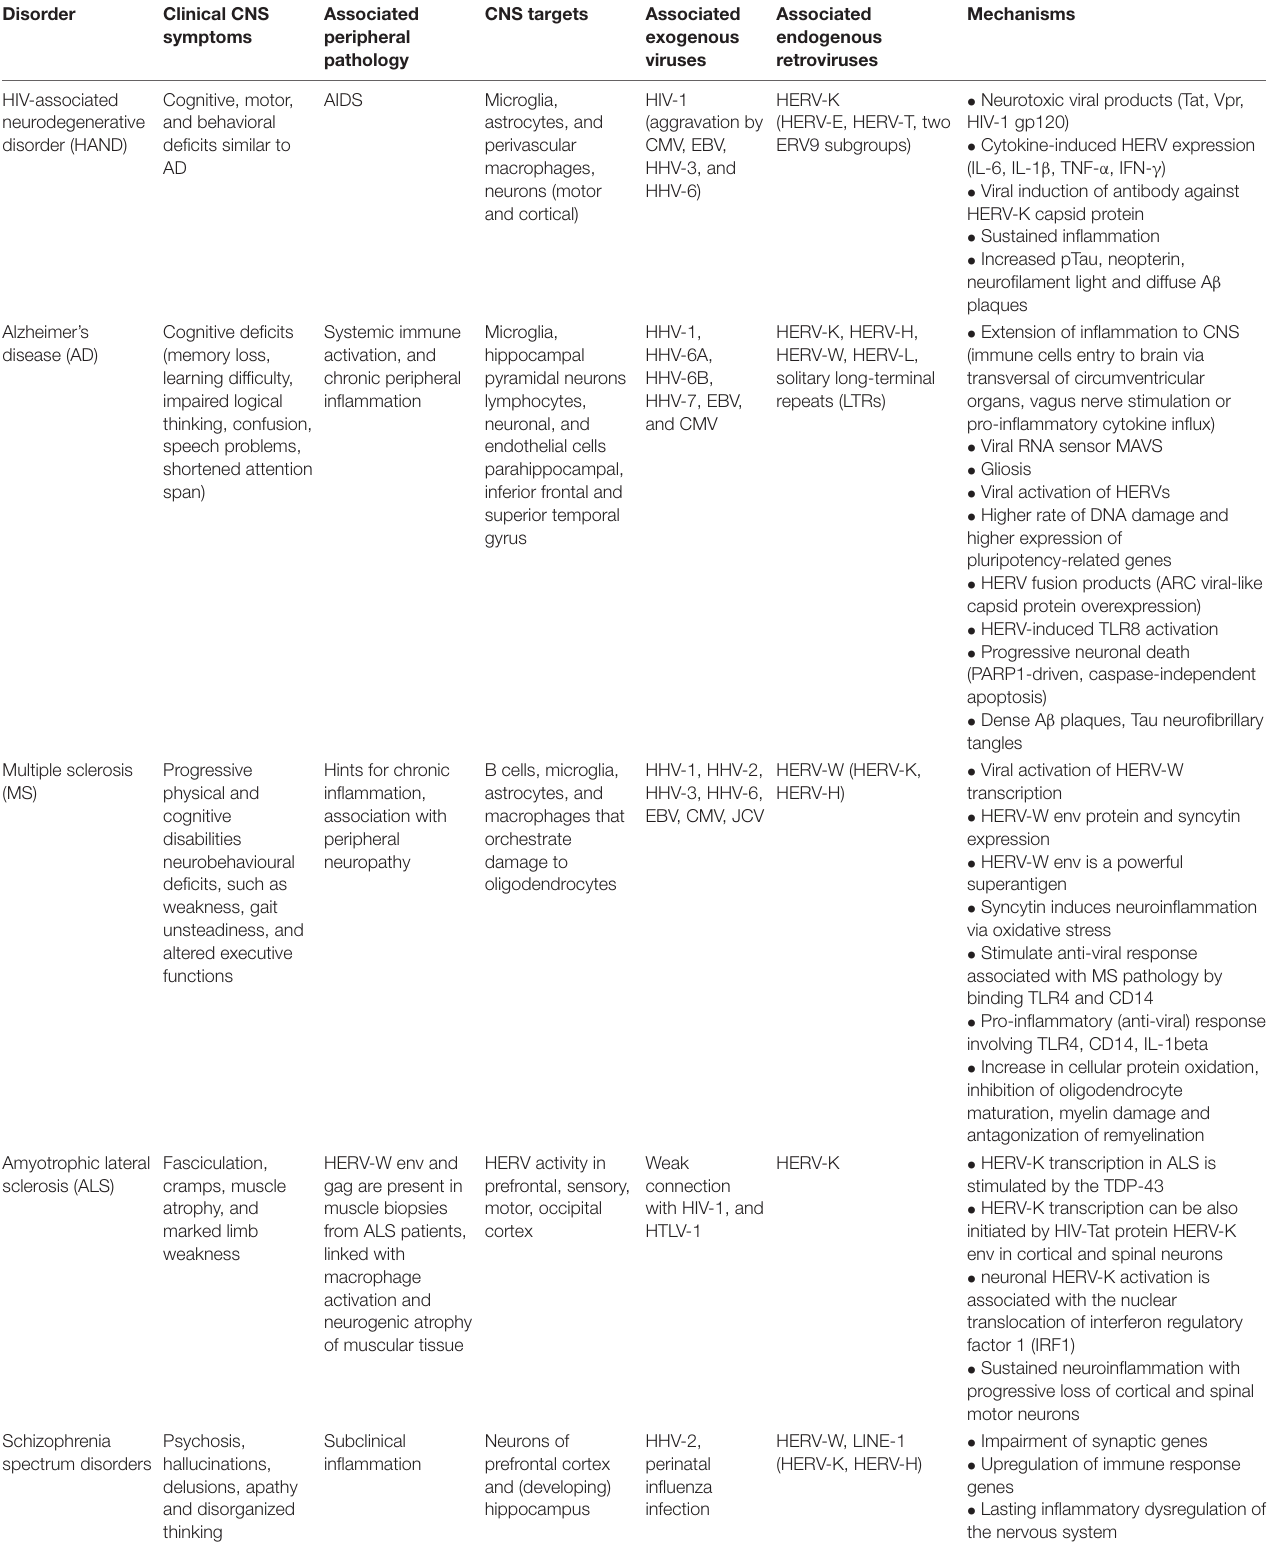
TABLE 1 | Overview of disorders affecting the central nervous system (CNS) associated with an onset mediated by exogenous viruses and/or endogenous